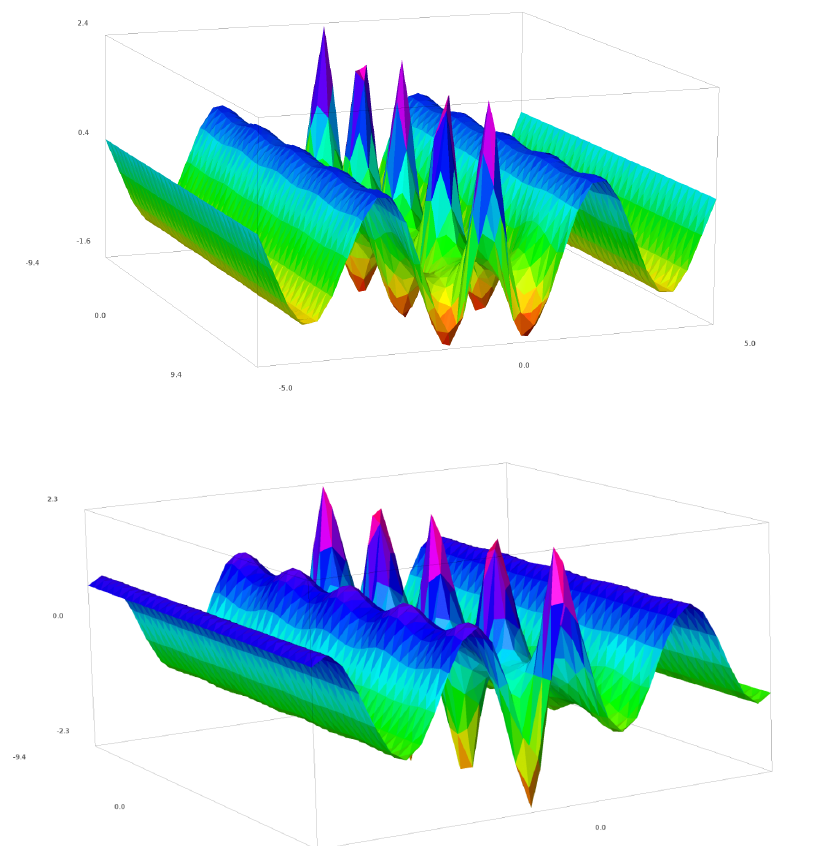
Figure 5. The selected wavefunction from the Osborne models [37]. ( Top ) Real part; ( Bottom ) imaginary part. Plotted with SAGEMATH